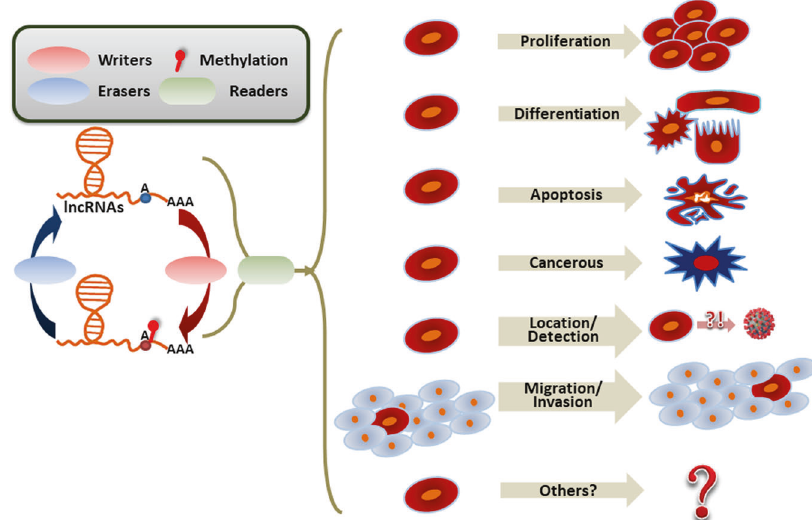
Fig. 1 Dynamics and functions of m 6 A processes in lncRNAs. The m 6 A modi fi cation procedure is dynamic and invertible. The enzymes in m 6 A modi fi cation regulation incorporate “ writers ” and “ erasers ” , which respectively assemble and dislodge the methylation and can